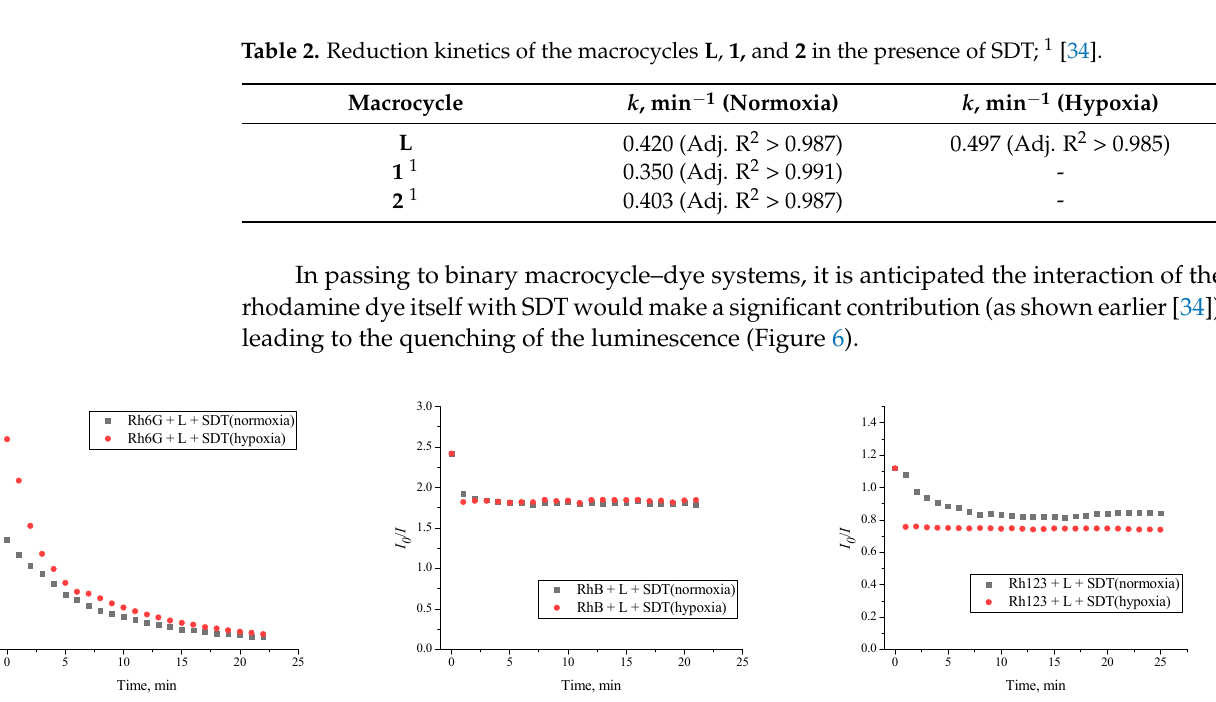
Figure 6. I 0 / I vs time for rhodamine dye-thiacalixarene L systems in the presence of SDT under normoxia and hypoxia. I 0 is the fluorescence intensity of the free dye. C (dye) = 1 μ M, C ( L ) = 1 μ M, C (SDT) = 100 μ M, PBS buffer (pH 7.4).